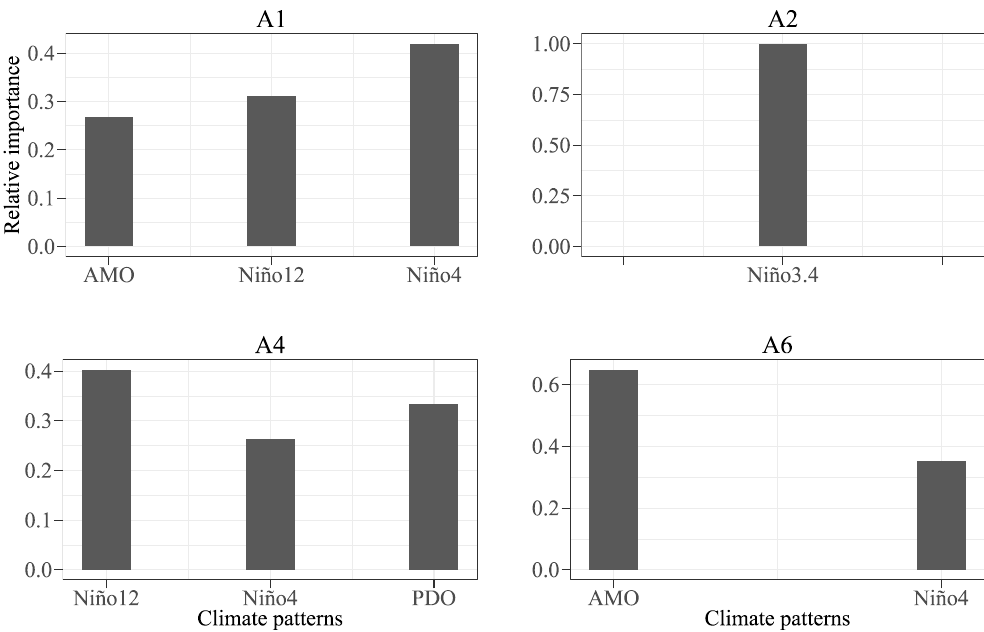
Figure 7. Relative importance of the identified climate patterns for each archetype.